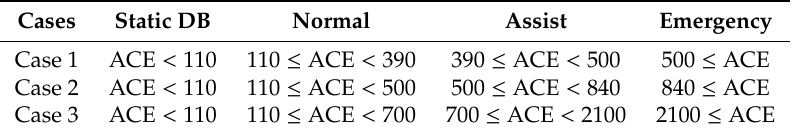
Table 1. Bounds of the control mode (ACE: Area Control Error; Static DB: Static Deadband).